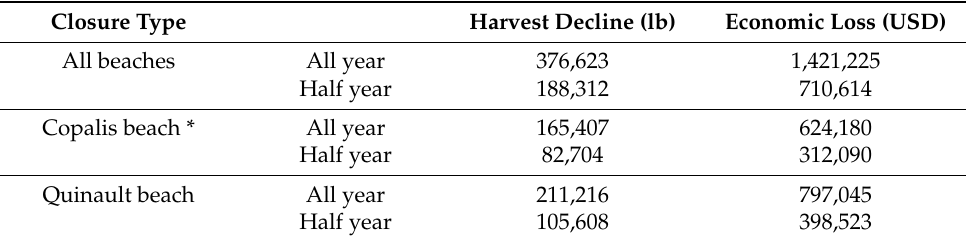
Table 1. Economic impacts of HABs on the Quinault Indian Nation commercial fishery. Data are based on average annual harvest during